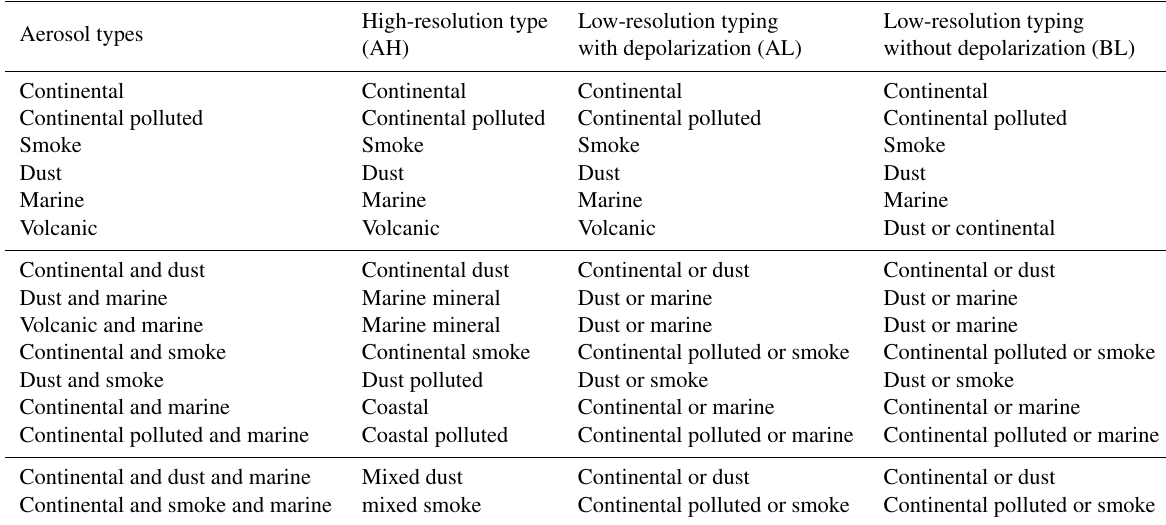
Table 4. Correspondence between the aerosol types defined in the algorithm, as they can be retrieved by NATALI in high resolution and low